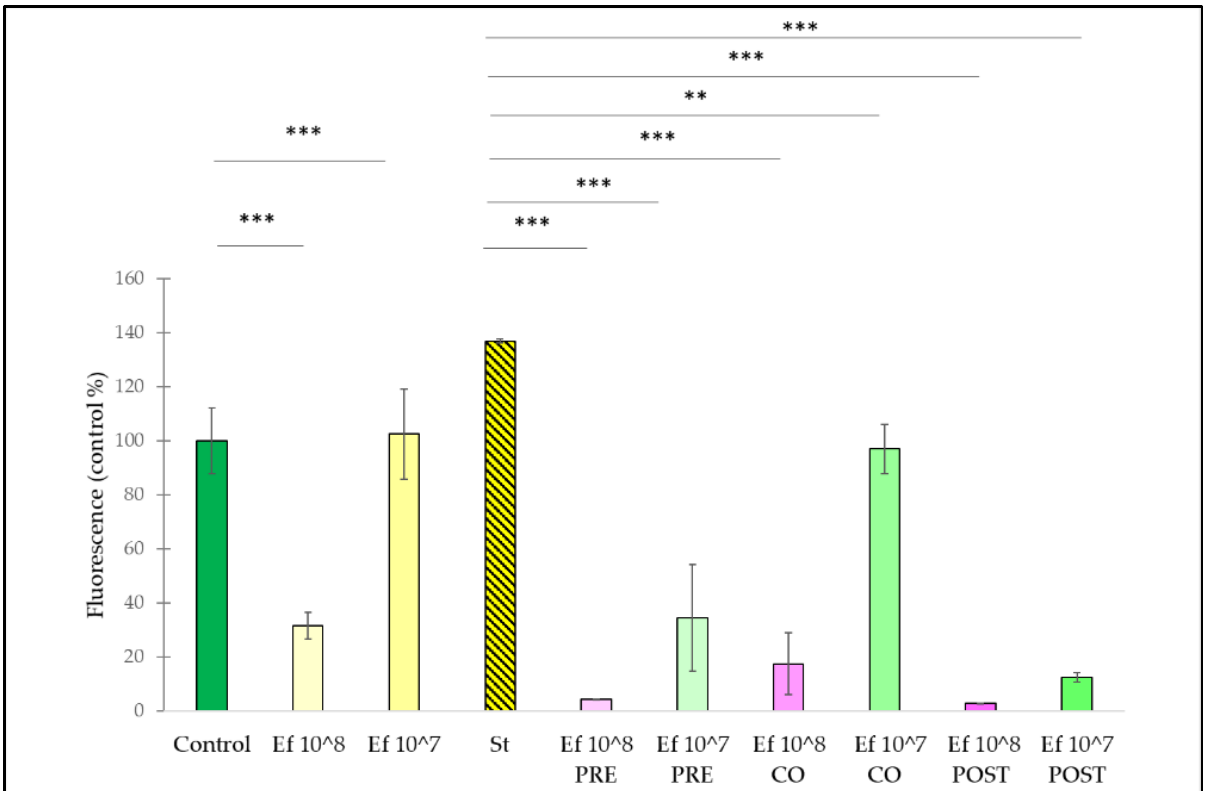
Figure 3. Amount of intracellular ROS after treatment with S. Typhimurium and E. faecium and their combinations. E. faecium was added 1 h before (pre-treatment), at the same time (co-treatment) or after (post-treatment) the addition of S. Typhimurium. E. faecium was added in 10 8 CFU/mL or in 10 7 CFU/mL concentration. Control : plain cell culture medium treatment; St : S. Typhimurium 10 6 CFU/mL; Ef 10ˆ8 : E. faecium 10 8 CFU/mL; Ef 10ˆ7 : E. faecium 10 7 CFU/mL; Ef 10ˆ8 PRE : pre-treatment with E. faecium 10 8 CFU/mL + S. Typhimurium 10 6 CFU/mL; Ef 10ˆ7 PRE : pre-treatment with E. faecium 10 7 CFU/mL + S. Typhimurium 10 6 CFU/mL; Ef 10ˆ8 CO : co-treatment with E. faecium 10 8 CFU/mL + S. Typhimurium 10 6 CFU/mL; Ef 10ˆ7 CO : co-treatment with E. faecium 10 7 CFU/mL + S. Typhimurium 10 6 CFU/mL; Ef 10ˆ8 POST : post-treatment with E. faecium 10 8 CFU/mL + S. Typhimurium 10 6 CFU/mL; Ef 10ˆ7 POST : post-treatment with E. faecium 10 7 CFU/mL + S. Typhimurium 10 6 CFU/mL. Data are shown as means with standard deviations, n = 6/group. ** p ≤ 0.01; *** p ≤ 0.0001. Treatment with E. coli caused an increase in the fluorescence compared to the control (Figure 4). The pre-treatment with E. faecium significantly reduced the amount of reactive oxygen species in the cells compared with samples only treated with E. coli . Both applied concentrations (10 8 CFU/mL and 10 7 CFU/mL) of E. faecium resulted in a significant decrease in reactive oxygen species. The same could be observed in the case of co-treatments and